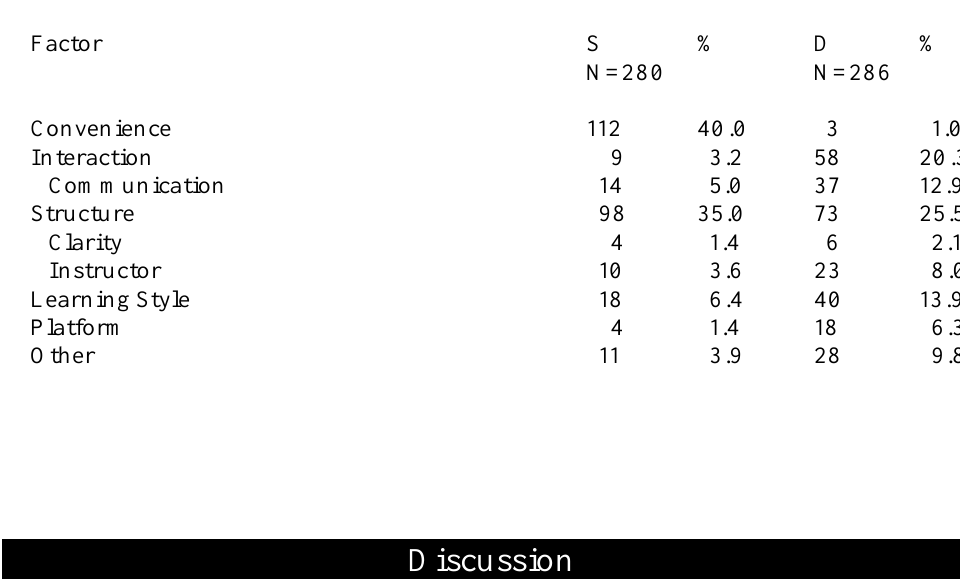
Factors Influencing Satisfaction/Dissatisfaction with Online